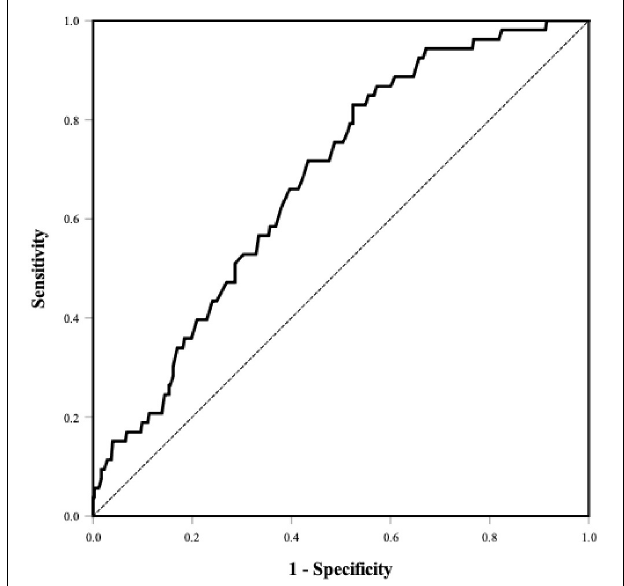
FIGURE 2 | ROC curve of the PNI for predicting LAAT/dense SEC. Area under the curve was 0.68 (95% CI, 0.61–0.75, P < 0.001). The optional cutoff value of the PNI was 48.0 (sensitivity 83.0%, specificity 47.6%). PNI, prognostic nutritional index; LAAT, left atrial appendage thrombus; SEC, spontaneous echo